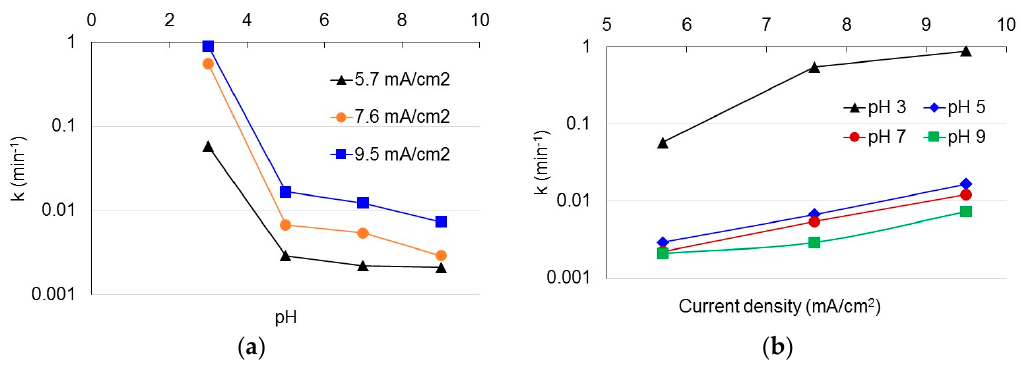
Figure 3. ( a ) Effect of pH and ( b ) current density on degradation rate constants of acetaminophen.